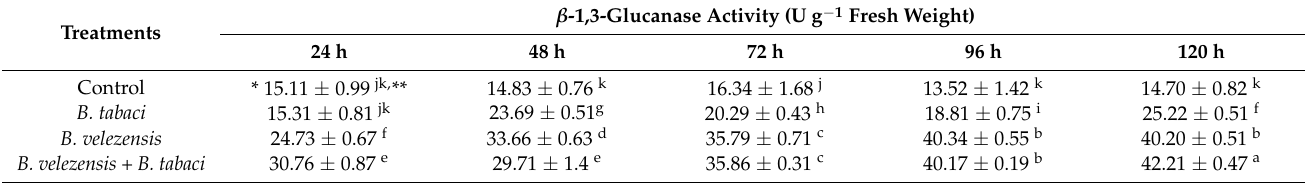
Table 1. The time-course of β -1,3-glucanase activity in squash plants exposed to Bemisia tabaci and Bacillus velezensis , and both agents compared with control.